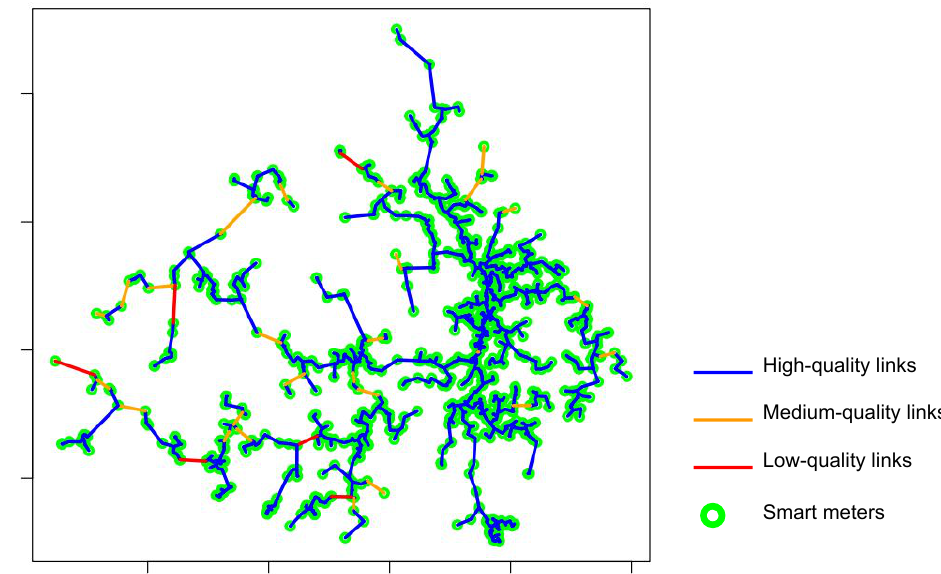
Figure 3. Example of MST with edges colored according to the LRP values.